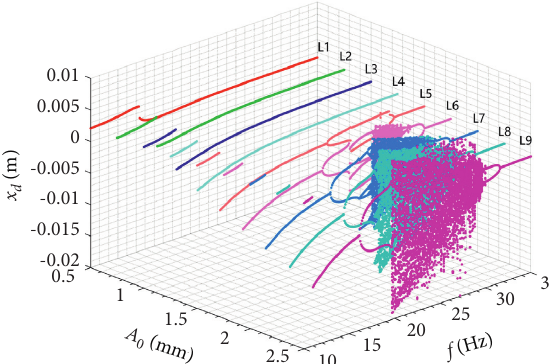
Figure 11: Bifurcation diagrams with excitation frequency f as bifurcation parameter under different nominal amplitudes ( k s � 70 MN/m and c s � 130 kNs/m). Figure 10: The contact forces F � 85MN/m). s ( k s